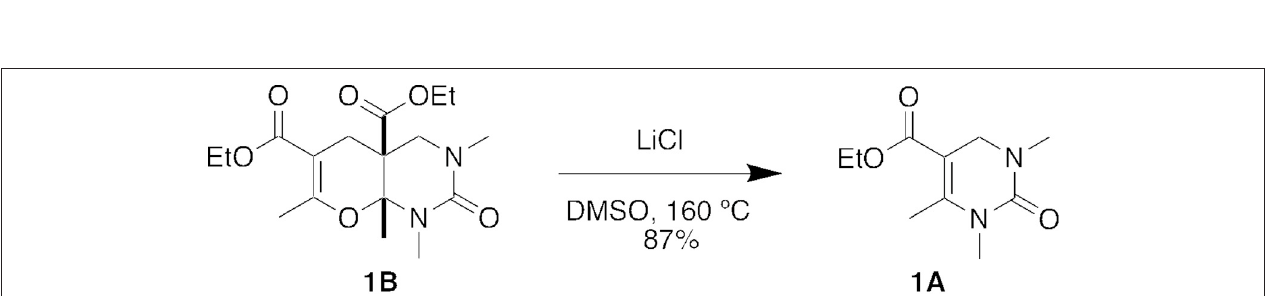
FIGURE 6 | Retro Diels-Alder reaction under Krapcho dealkylation conditions.